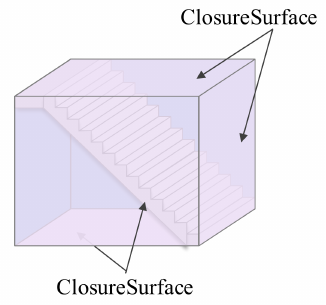
Figure 15. Simplification of stairs.